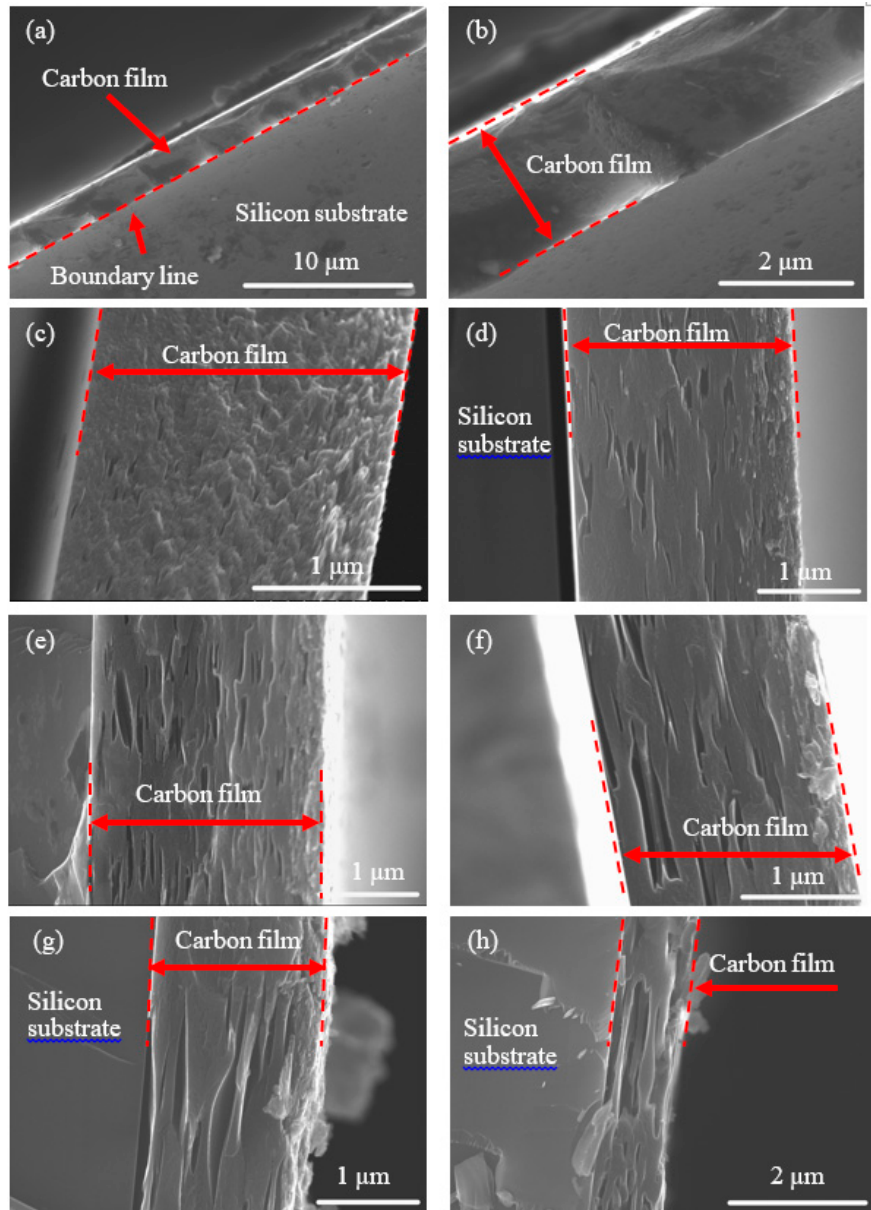
Figure 6. The SEM micrographs showing the cross-section of carbon films prepared from polymer films: ( a ) and ( b ) pure PAN, ( c ) PAN/PET-10-250, ( d ) PAN/PET-20-250, ( e ) PAN/PET-25-250, ( f ) PAN/PET-30-250, ( g ) PAN/PET-35-250, and ( h )